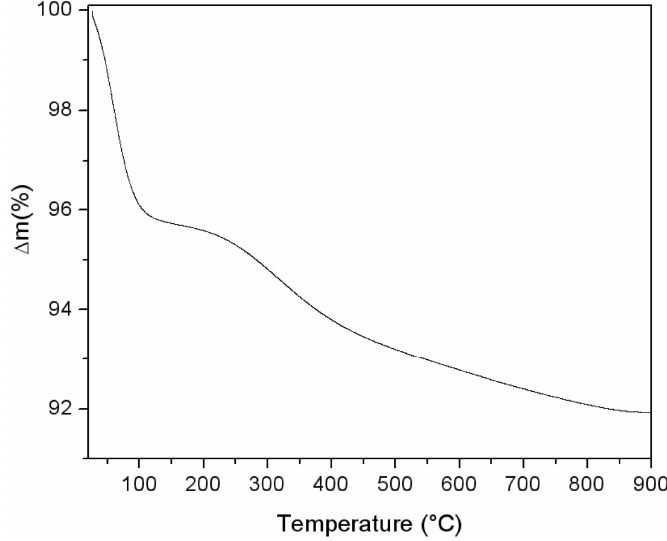
Figure 3. Thermogravimetric analysis performed on pyrogenic silica under argon atmosphere (5 °C/min).